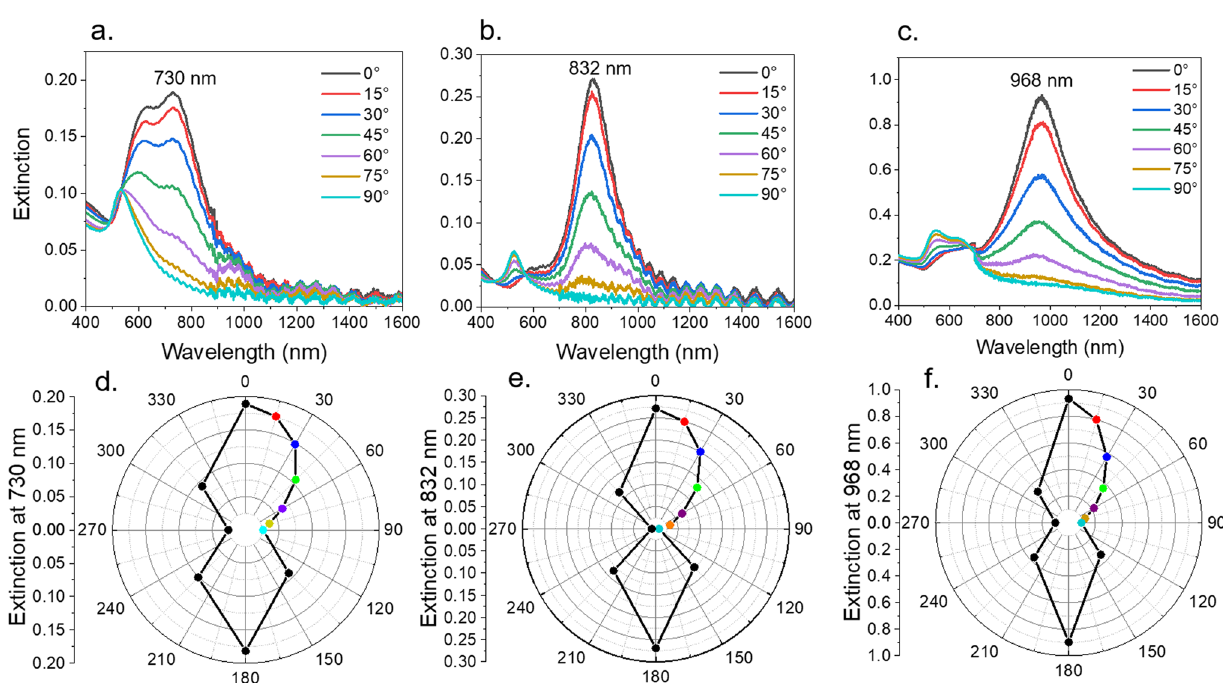
Figure 4. Polarized absorption spectra of aligned AuNPs. Polarized extinction spectra of 20 nm ( a ), 50 nm ( b ), and 80 nm ( c ) AuNPs on wrinkled graphene. Polar plots show the extinction values at λ max at each polarization angle for 20 nm ( d ), 50 nm ( e ), and 80 nm ( f )